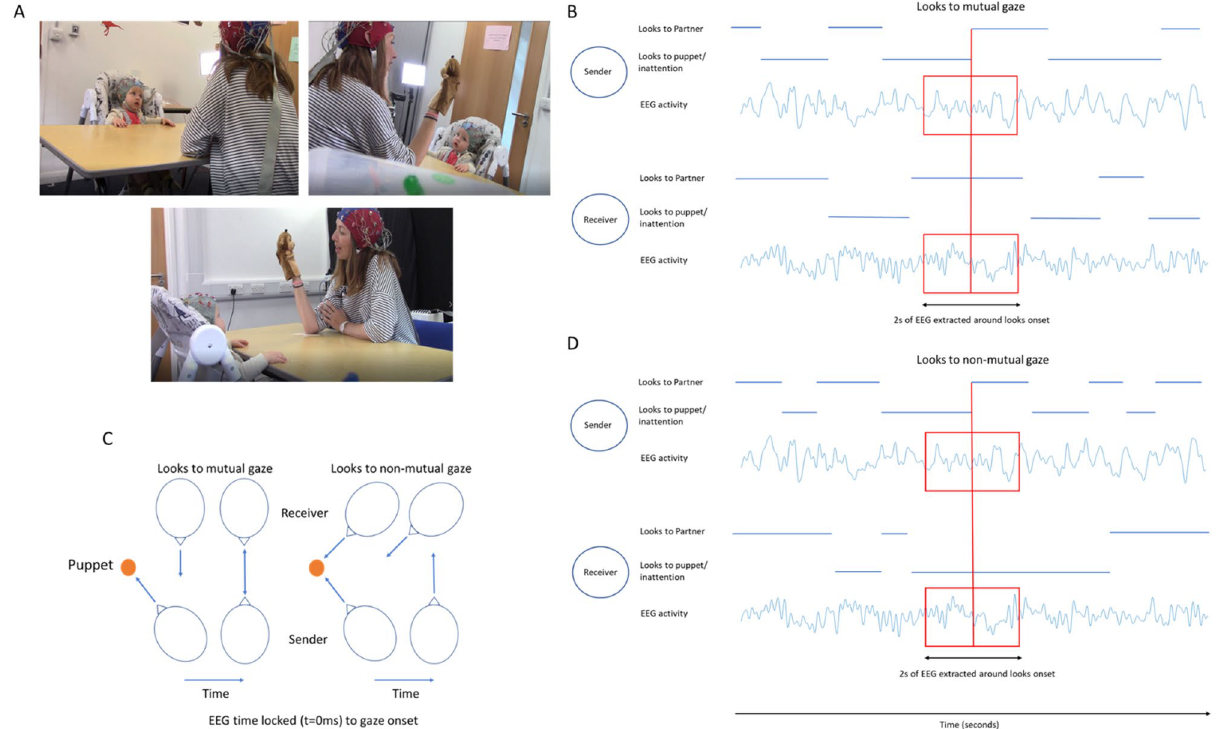
Figure 1. Illustration of experimental set-up and design for event locked analysis. ( A ) shows screenshots of experimental recordings from three camera angles used. ( B ) shows event locking process for sender and receiver EEG activity relative to mutual gaze onsets. Here receiver’s gaze was maintained on the sender and the sender’s gaze shifted from looking at the puppet/inattention toward looking at the receiver, facilitating mutual gaze. ± 1 s of EEG activity was extracted around gaze shift. ( C ) shows topographical illustration of sender’s and receiver’s gaze relative to mutual and non-mutual gaze onsets. ( D ) shows event locking process for sender and receiver EEG activity relative to mutual gaze onsets. Here receiver’s gaze was maintained on either the puppet (or inattention) and the sender’s gaze shifted from looking at the puppet/inattention toward looking at the receiver, facilitating non-mutual gaze. ± 1 s of EEG activity was extracted around gaze